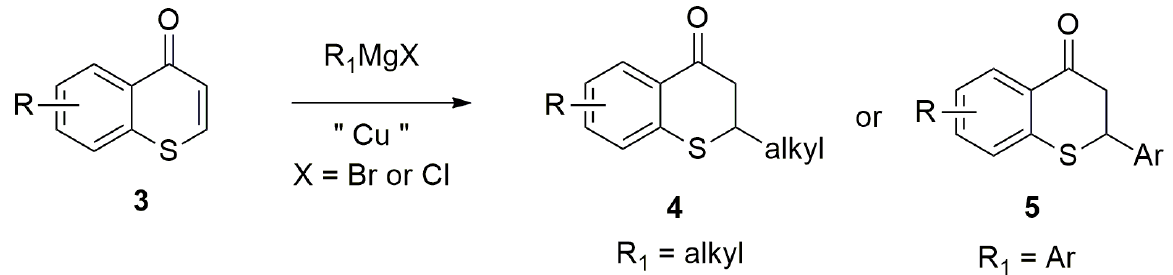
Figure 3. Copper-Catalyzed Conjugate Addition of Grignard Reagents to Thiochromones. The investigation started with n -butylmagnesium chloride with thiochromone 3A (Figure 4). It was reported that an excellent yield (89%) of 1,4-adduct, 2- n -butylthiochroman-4-one 4a can be attained when TMSCl was used as the additive with 2.0 equivalent of LiCl and 1.0 equivalent of CuCN (Figure 4). The optimization of reaction conditions found that the use of 0.2 equivalent of CuCN · 2LiCl offered the highest yield of 1,4-adduct with TMSCl as the additive. When a smaller amount of CuCN · 2LiCl (0.1 equivalent) was used, no significant change of the yield of 1,4-adduct 4a (85% vs. 89%) was observed [58].